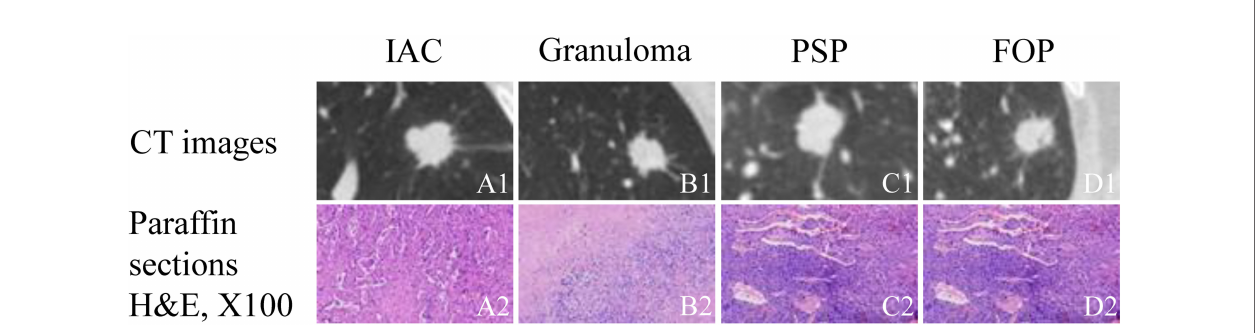
FIGURE 1 | Examples of solid, indeterminate SPN/SPMs without features strongly suggestive of a benign etiology. (A1) Invasive adenocarcinoma (IAC); (B1) granuloma; (C1) pulmonary sclerosing pneumocytoma (PSP); (D1) focal organizing pneumonia (FOP). (A2 – D2) paraf fi n section (hematoxylin and eosin [H&E], 100 ×) of IAC, granuloma, PSP, and